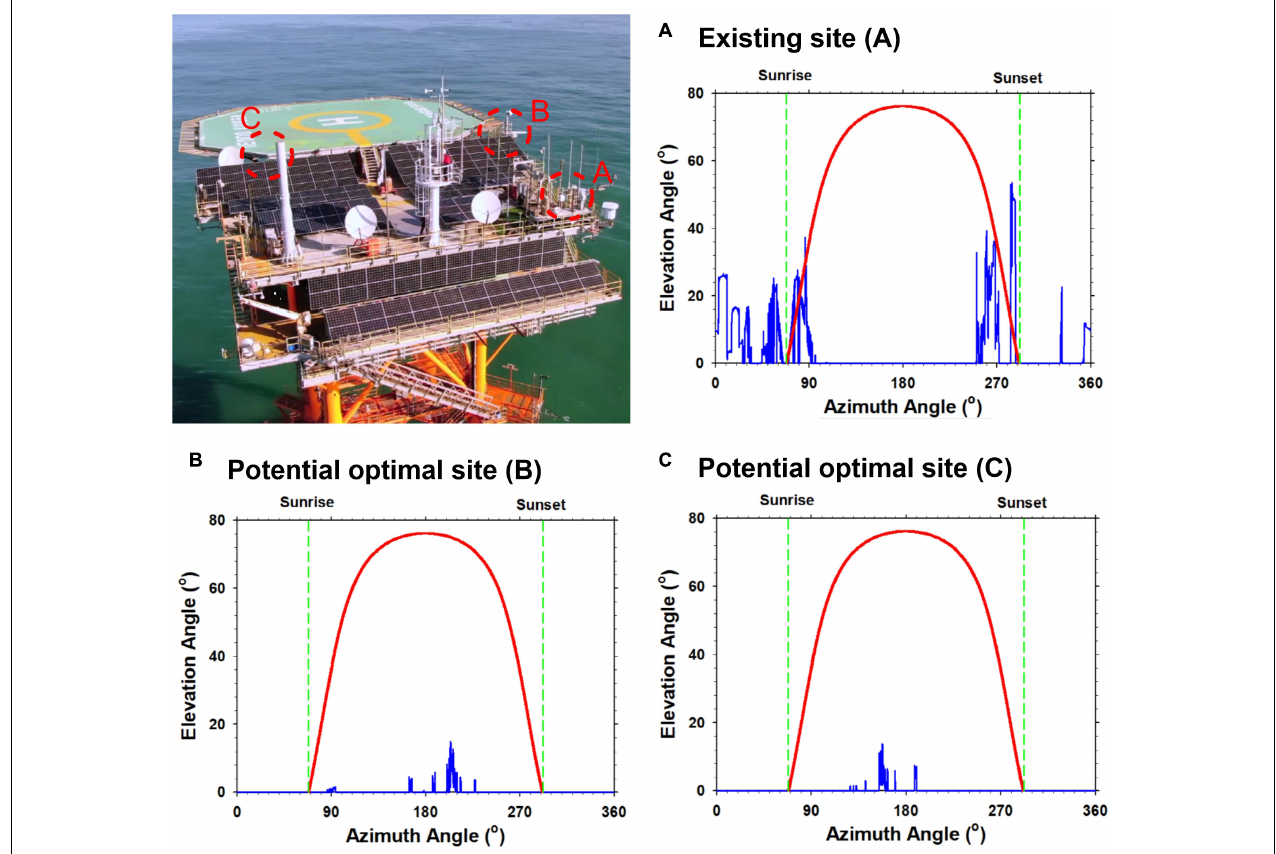
FIGURE 14 | The results of shade analyses for (A) the existing radiation observation site (A) and (B,C) potential optimal sites (B,C) at Ieodo ORS. Blue and red lines in each panel denote the altitudes of surrounding devices’ direct sunlight obstruction effects and of the Sun, respectively, as measured on October 28, 2019. Green dashed lines denote azimuth angels at sunrise and sunset on October 28,